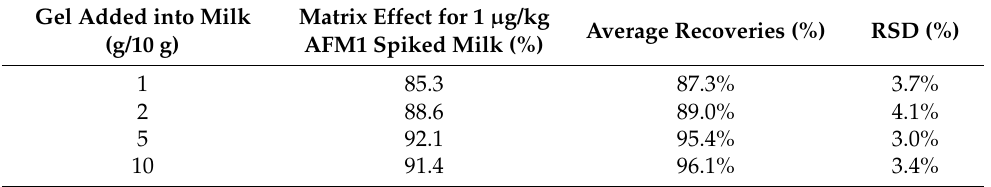
Table 1. Comparison of different types and proportions of protein precipitants ( n =